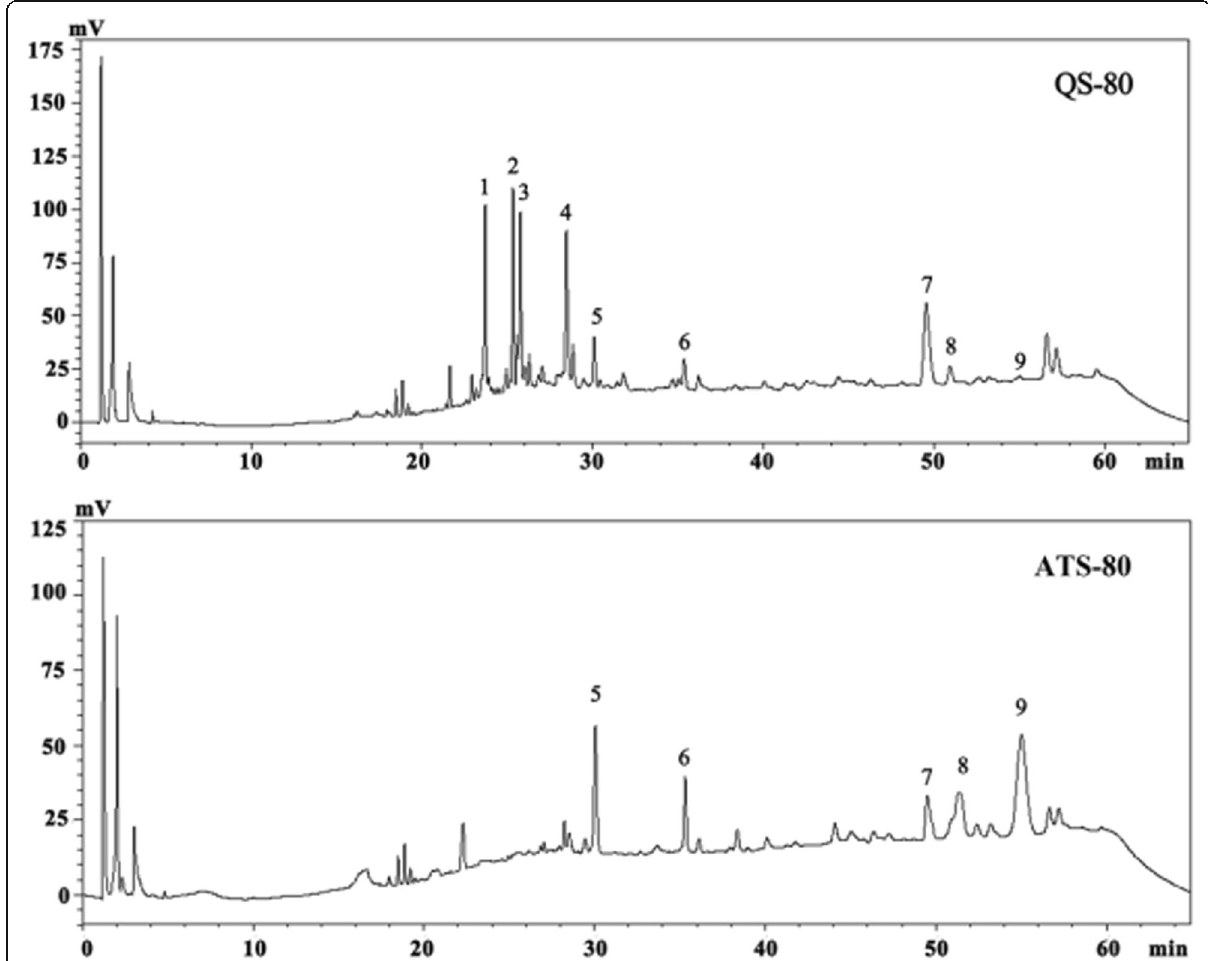
Fig. 1 HPLC chromatograms of QS-80 and ATS-80. QS-80 and ATS-80 were the 80% methanol-eluted fractions from quinoa saponin and alkali-transformed quinoa saponin,